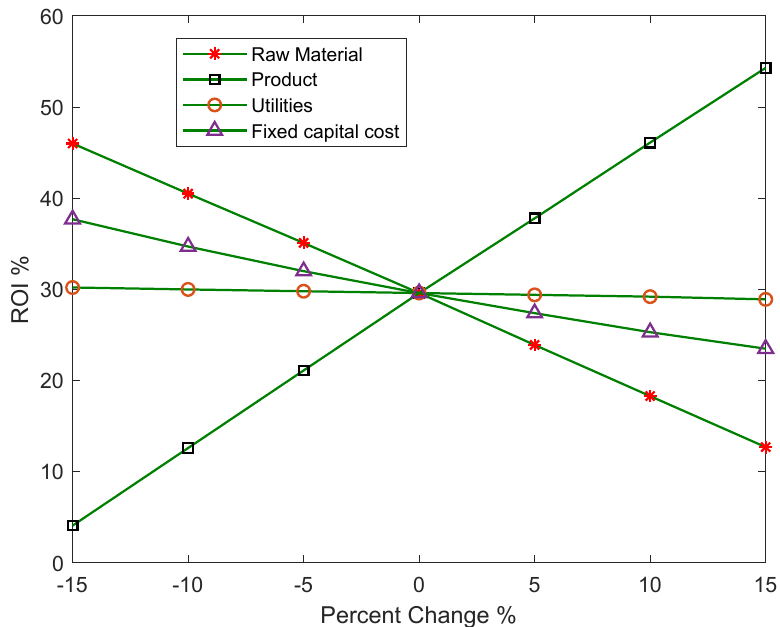
Figure 7. Return on investment under various market variations of the economic factors.